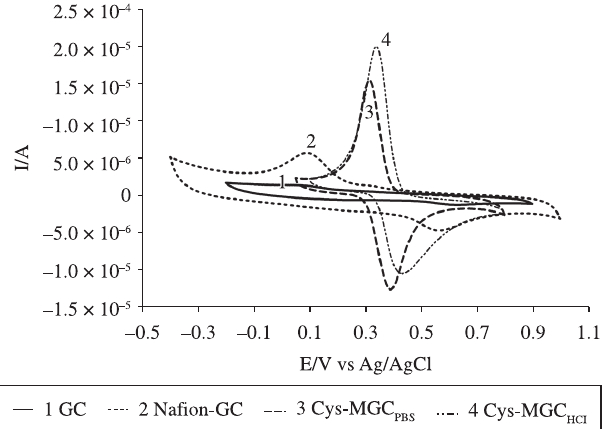
Figure 3. Plot of the anodic (Ia) and cathodic (Ic) peak currents versus scan rates in the range of 20 to 120 mV.s –1 . Solution: 8.0 × 10 –5 mol.L –1 DA in PBS (pH 6) at 25 °C. Cys-MGC electrodes: ( ▲ , ∆ ) Cys-MGC Cys-MGC HCl